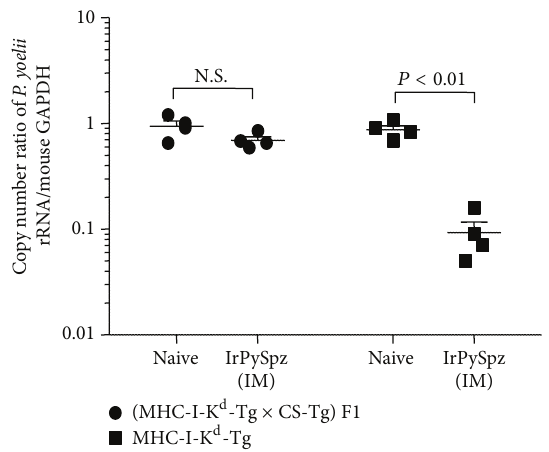
Figure 4: Protection against plasmodium infection in IrPySpz- immunized MHC-I- 𝐾 𝑑 -Tg mice and (MHC-I- 𝐾 𝑑 -Tg × CS-Tg) F1 mice . (MHC-I-K d -Tg × CS-Tg) F1 mice were generated by crossing CS-Tg mice to MHC-I-K d -Tg mice. Groups (4 mice per group) of naive MHC-I-K d -Tg mice and MHC-I-K d -Tg × CS-Tg mice were immunized with 5 × 10 4 IrPySpz via IM injection. Protection assay was performed by challenge with 1 × 10 4 infectious P. yoelii sporozoites via IV injection 2 weeks after immunization. Na¨ıve MHC-I-K d -Tg mice and (MHC-I-K d -Tg × CS-Tg) F1 mice were also challenged as infection controls. The value of parasite burden was described